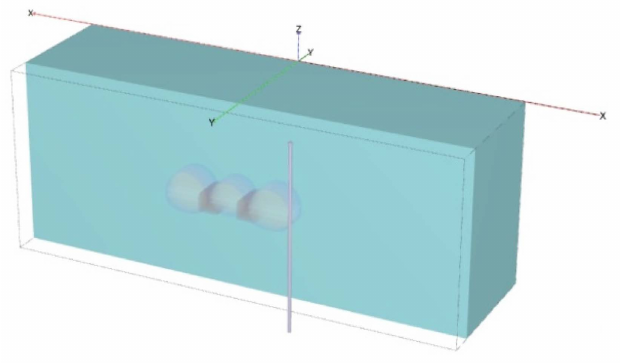
Figure 16. Schematic diagram of the analysis mode under unbiased pressure.